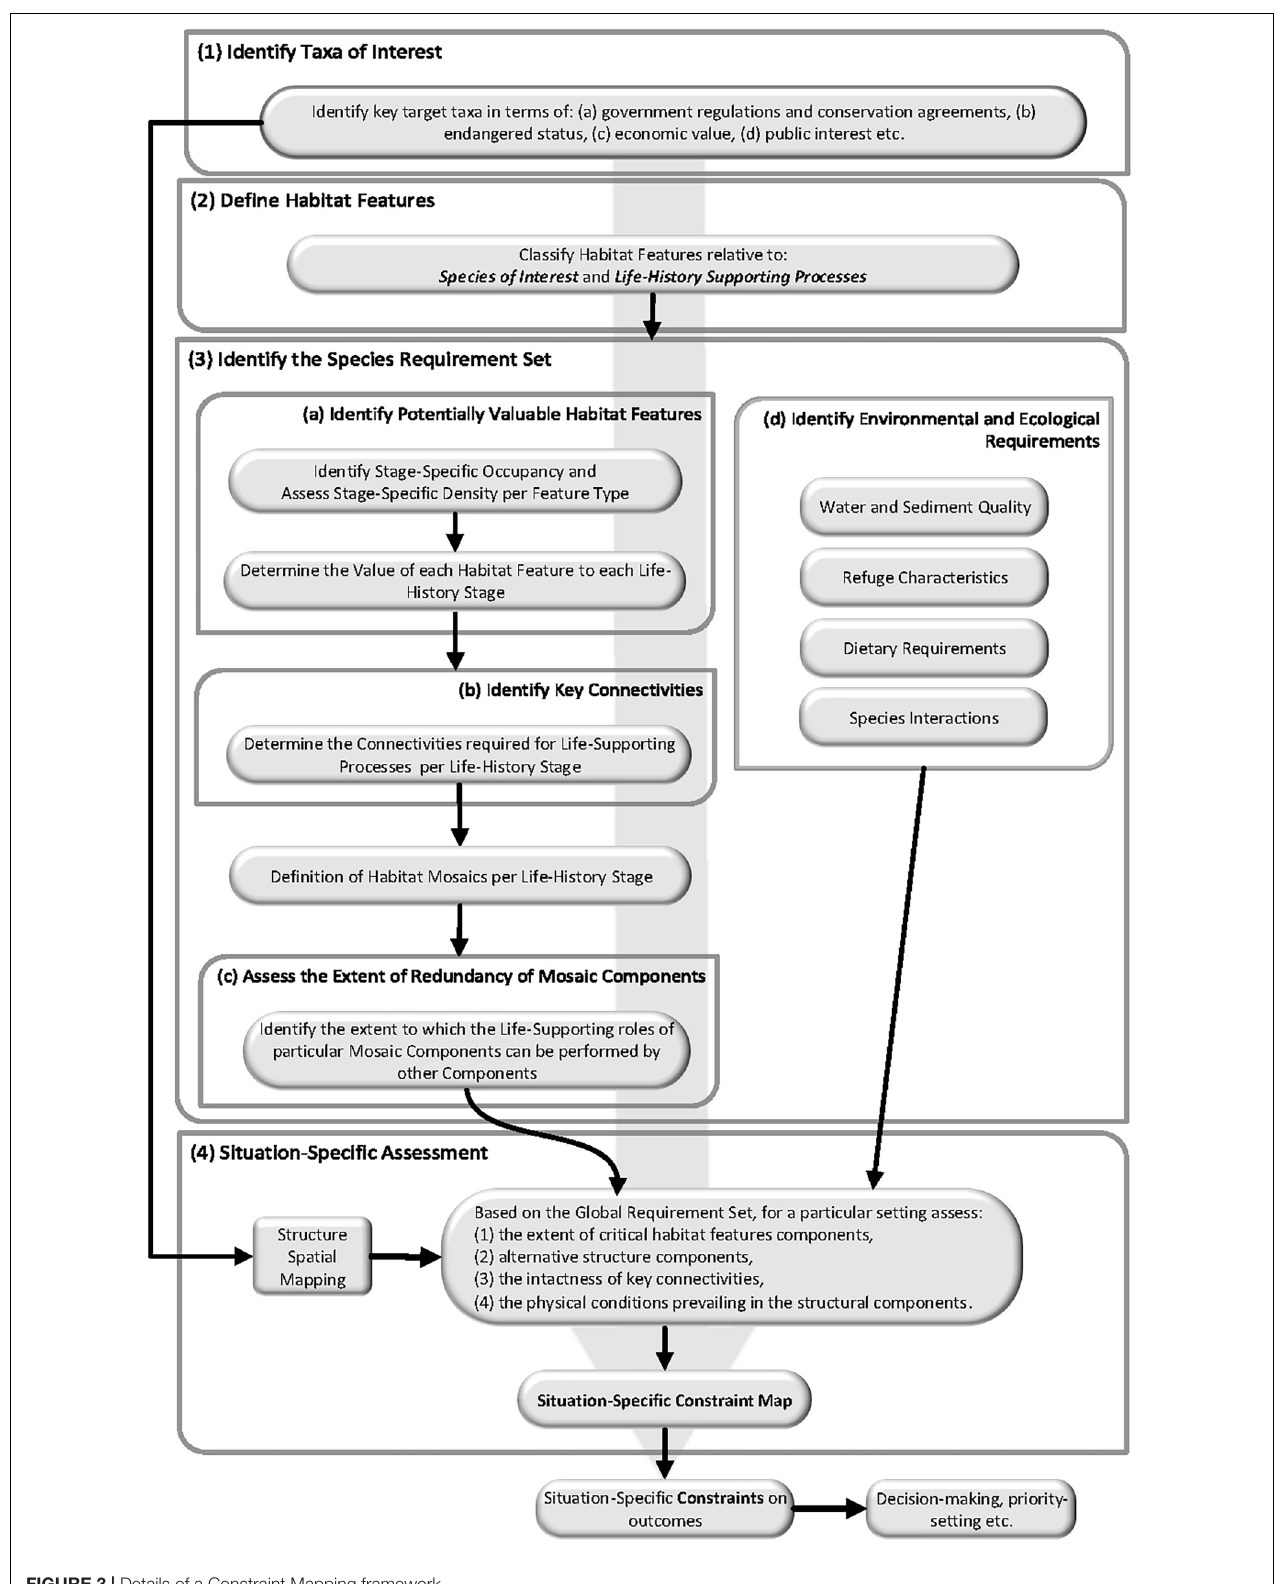
FIGURE 3 | Details of a Constraint Mapping